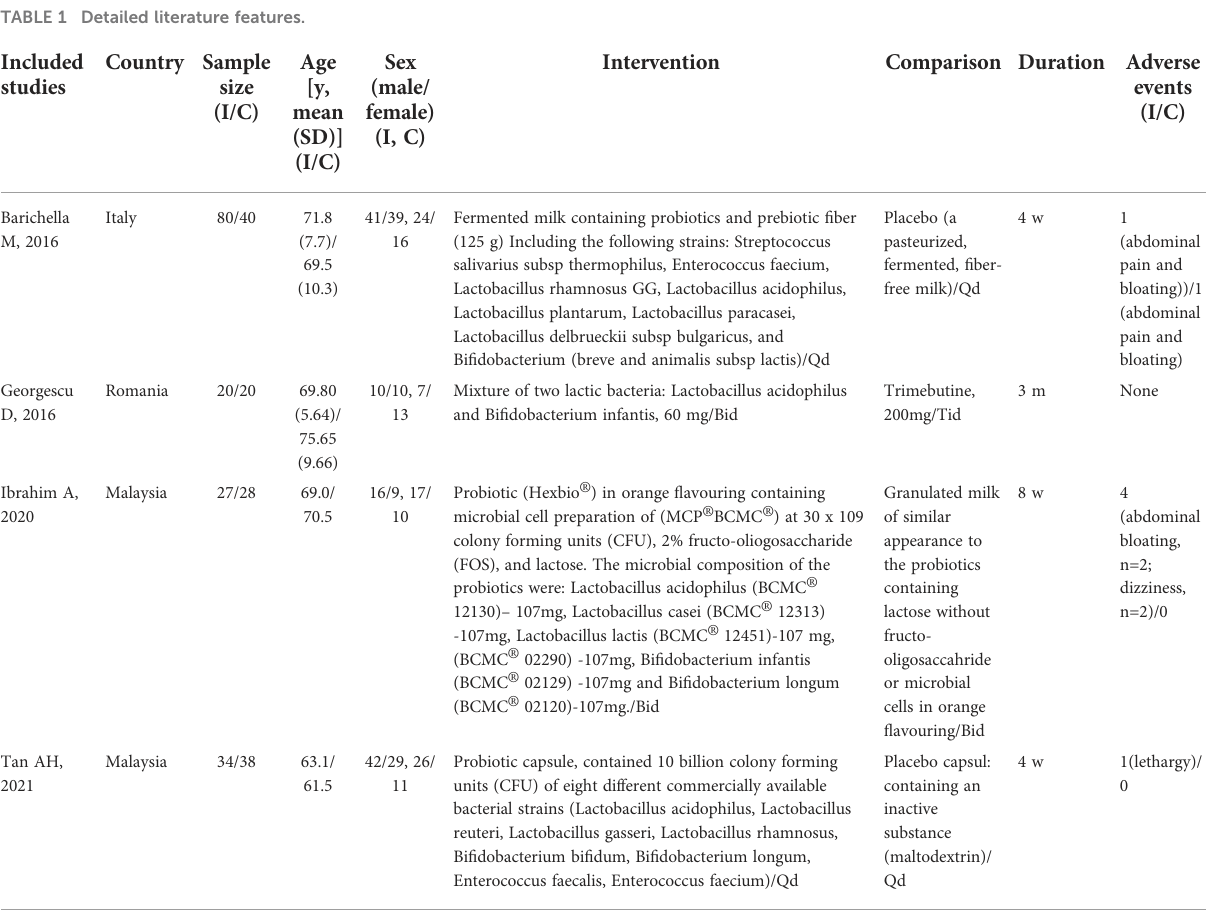
TABLE 1 Detailed literature features. Included Country Sample studies